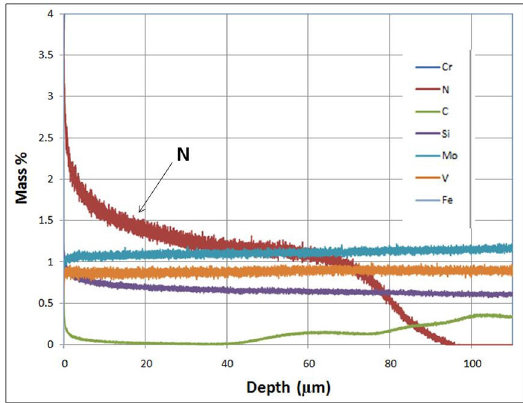
Figure 4. Results obtained from the GDOES elemental depth profile concentration analysis of the pre-nitrided steel substrate.